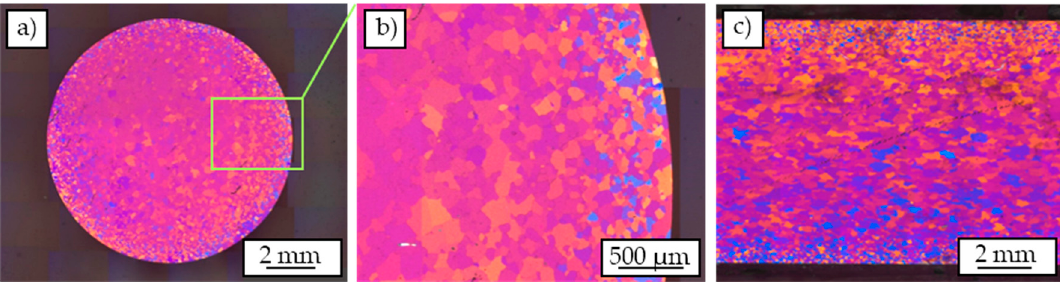
Figure 3. Micrographs of Barker-etched cast-based profile: overview of cross - section ( a ), detailed view of cross - section ( b ), and overview of longitudinal section ( c ).